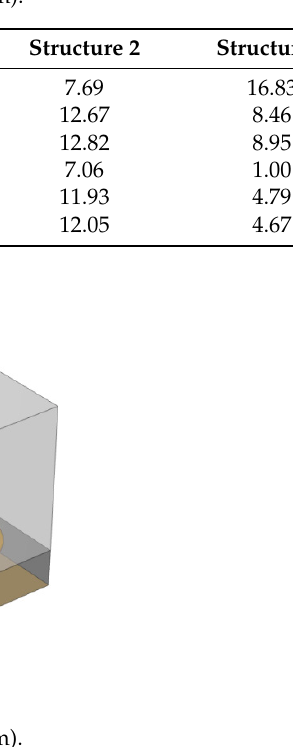
Table 5. Optimized parameters (one of them).